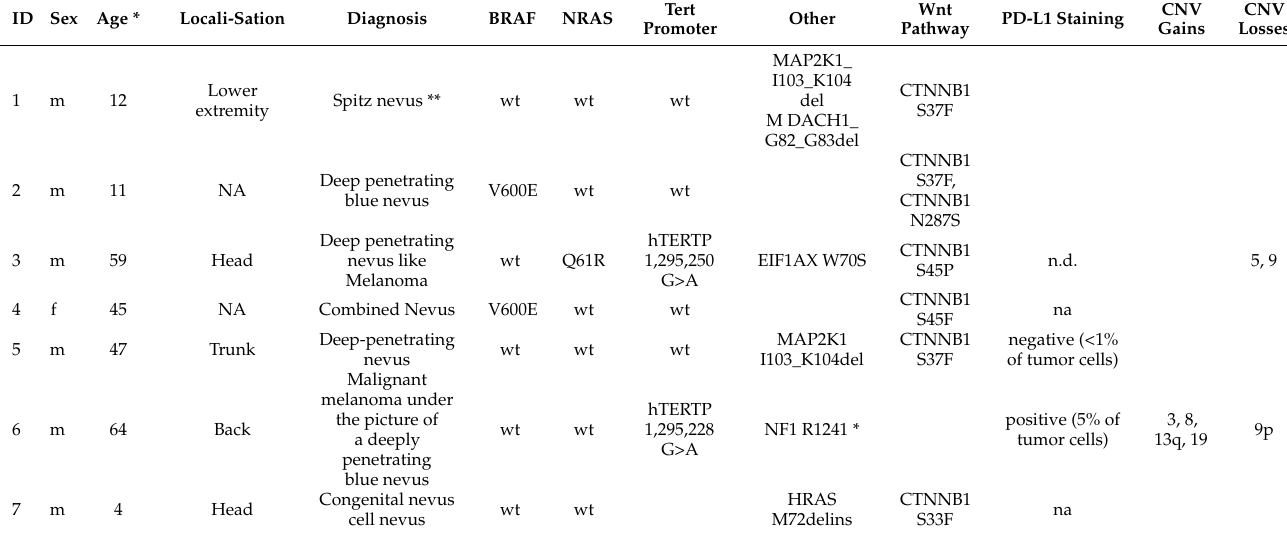
Table 1. Clinical and genetic